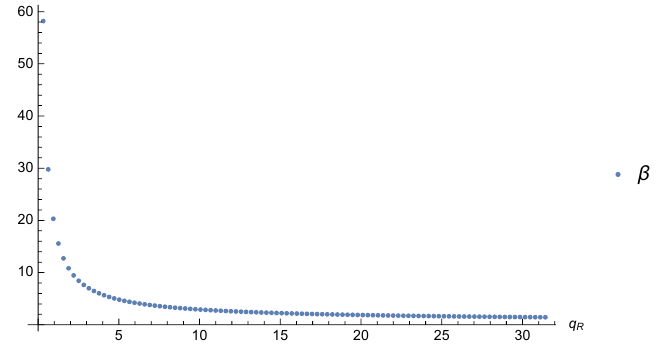
Figure 2 . Numerical values of ˆ β for Case 1 as a function of q R .